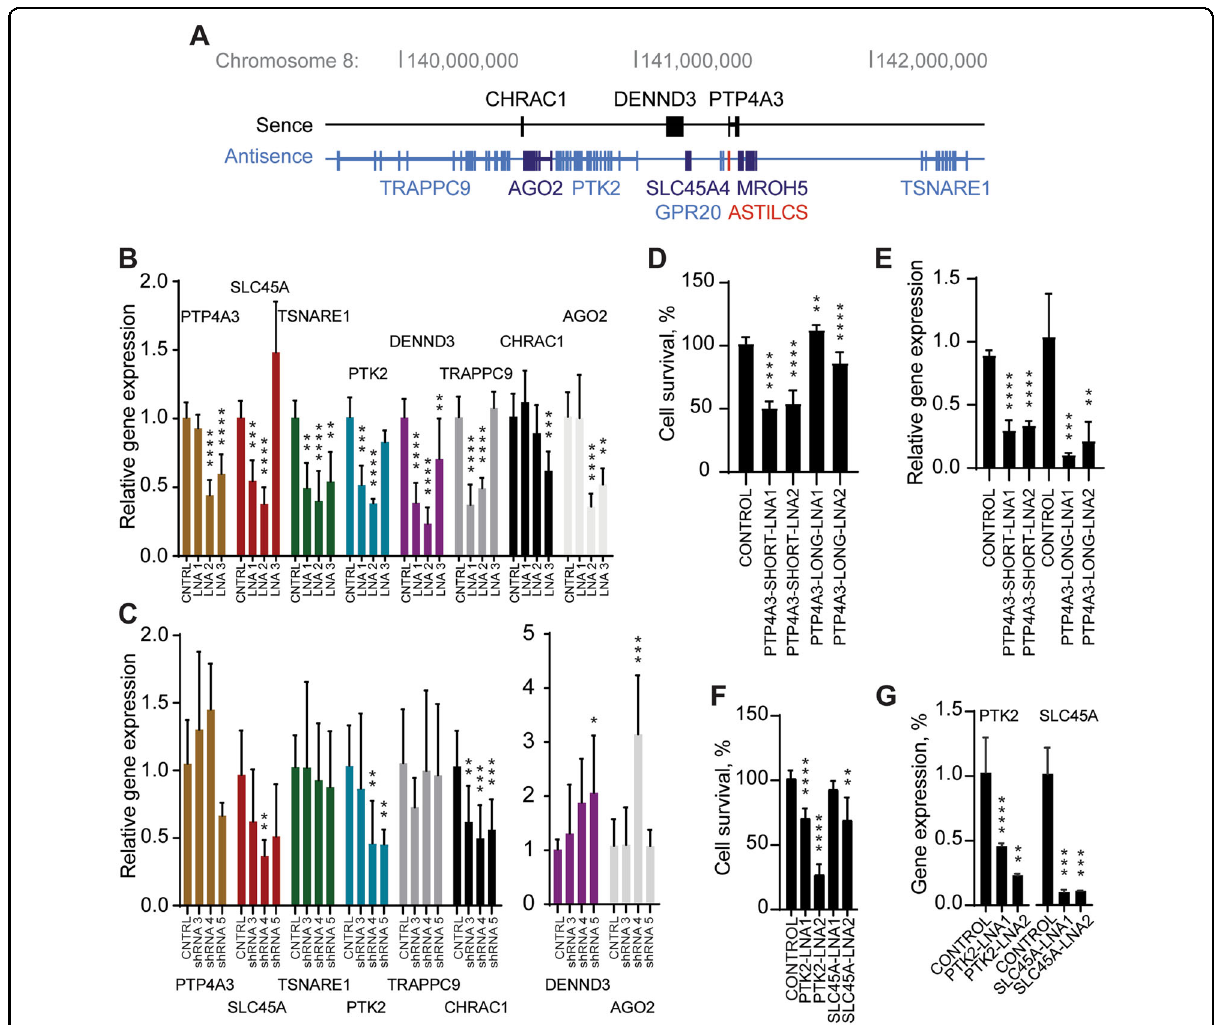
Fig. 4 Knockdown of ASTILCS results in dose-dependent downregulation of neighboring genes. A Genomic locus of ASTILCS. RNA expression of ASTILCS neighboring genes in HUH7 cells upon LNA gapmer-mediated ( n ≥ 8) ( B ) or shRNA-mediated ( n ≥ 5) ( C ) knockdown of ASTILCS. Cell survival ( n ≥ 8) ( D ) and gene expression ( n ≥ 5) ( E ) upon LNA-mediated silencing of PTP4A3 isoforms. Cell survival ( n ≥ 9) ( F ) and gene expression ( n ≥ 5) ( G ) upon LNA gapmer-mediated silencing of ASTILCS neighboring genes PTK2 or SCL45A, n ≥ 9. All values are mean ± SD, **** - p < 0.0001; *** - p < 0.001; ** - p < 0.01; * - p <